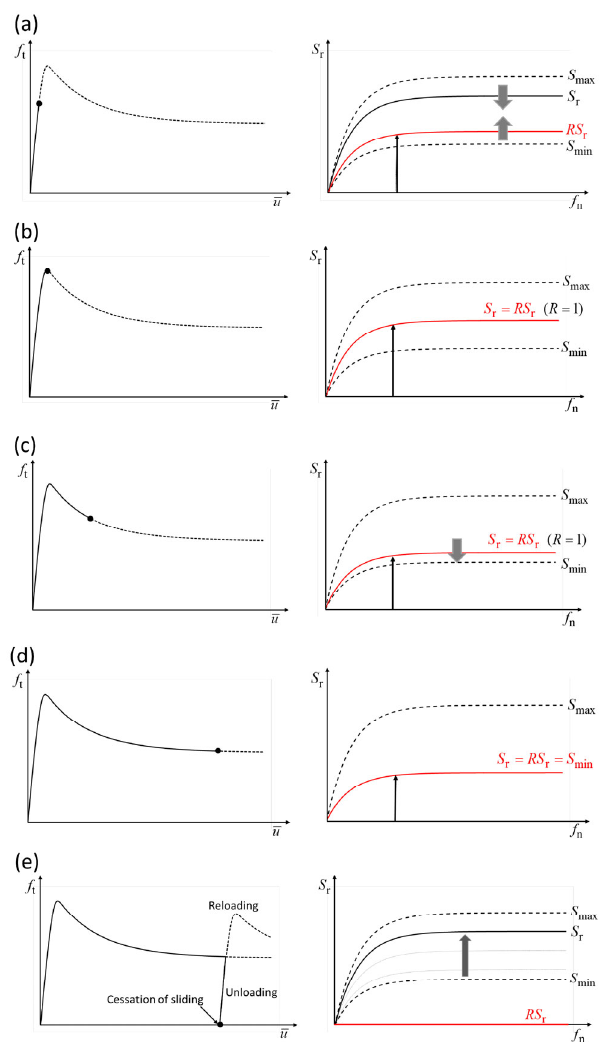
Fig. 3 Schematic response of rate-, state- and pressure-dependent SF model: (a) sub-sliding state ( R < 1); (b) maximum friction state; (c) sliding-weakening state; (d) minimum friction state; and (e) unloading and subsequent holding